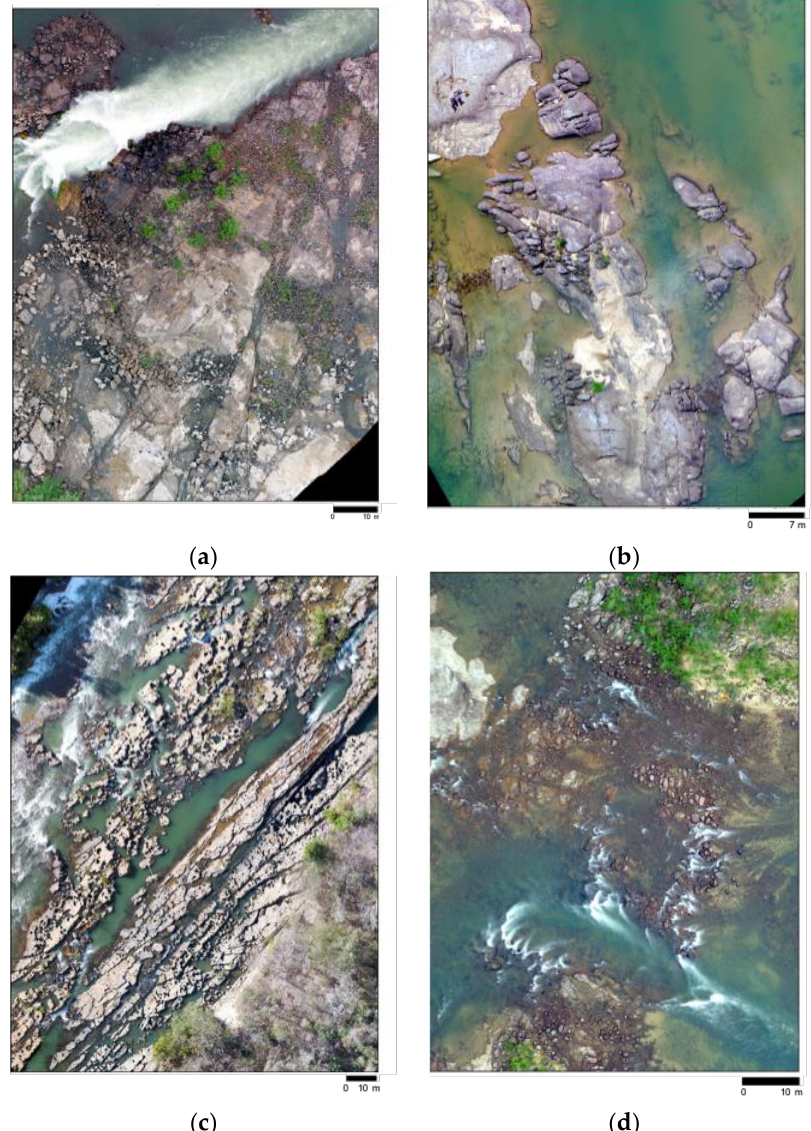
Figure 11. Orthomosaics generated from the UAV photographs of ( a ) Cachoeira Iriri, ( b ) Retroculus site, ( c ) Cachoeira Culuene and ( d ) Cachoeira do Xadá. Examples of the habitat classes ranging from sand and pebbles to large boulders exposed in the dry season. Areas of deep/turbid water and white water can also be seen. The four interactive 3D point clouds are available at: https://bit.ly/iriri3D, https://bit.ly/retroculus, https://bit.ly/culuene, https://bit.ly/xadarapids.